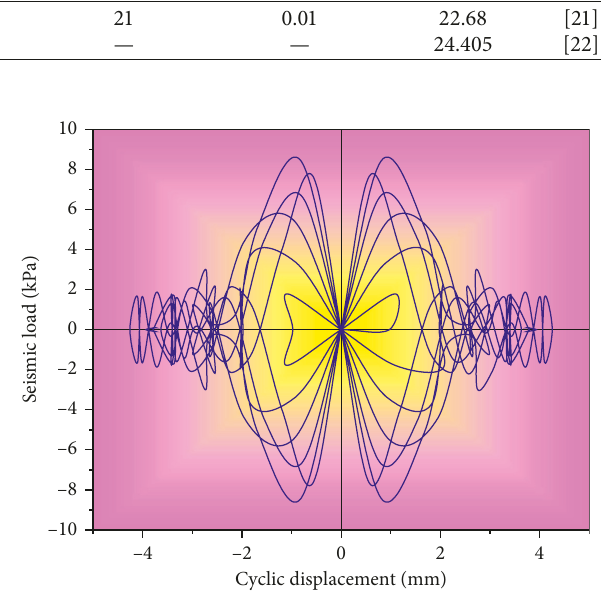
Figure 5: Seismic load (kPa) vs cyclic displacement (mm) at the base of a concrete footing, configuration-1.